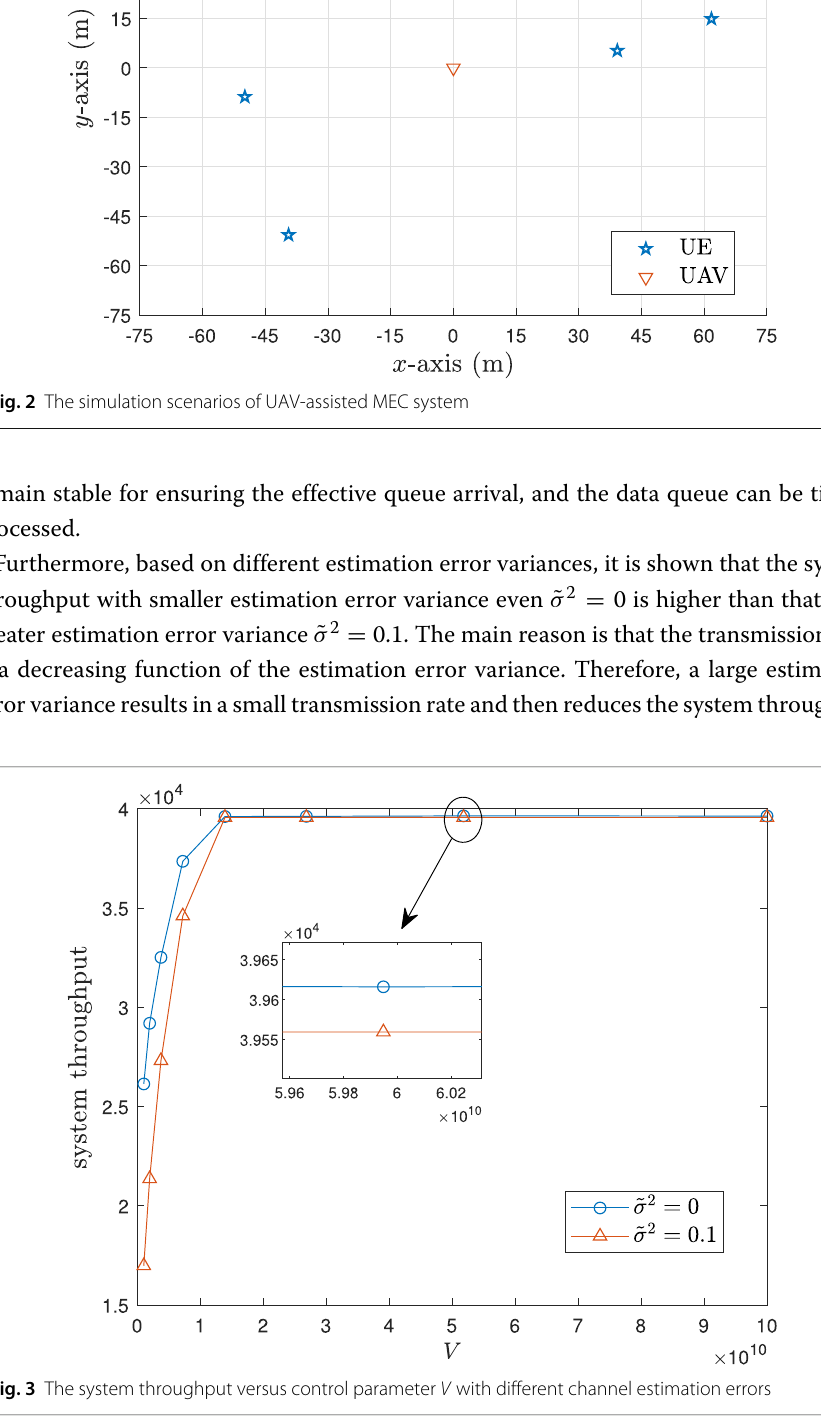
Fig. 3 The system throughput versus control parameter V with different channel estimation